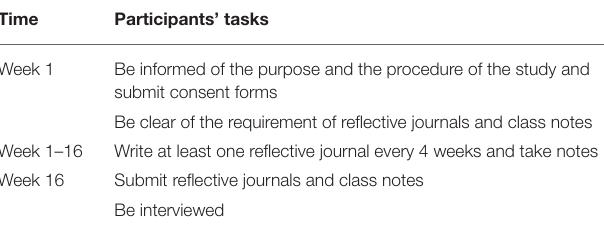
TABLE 3 | The timeline of the data collection